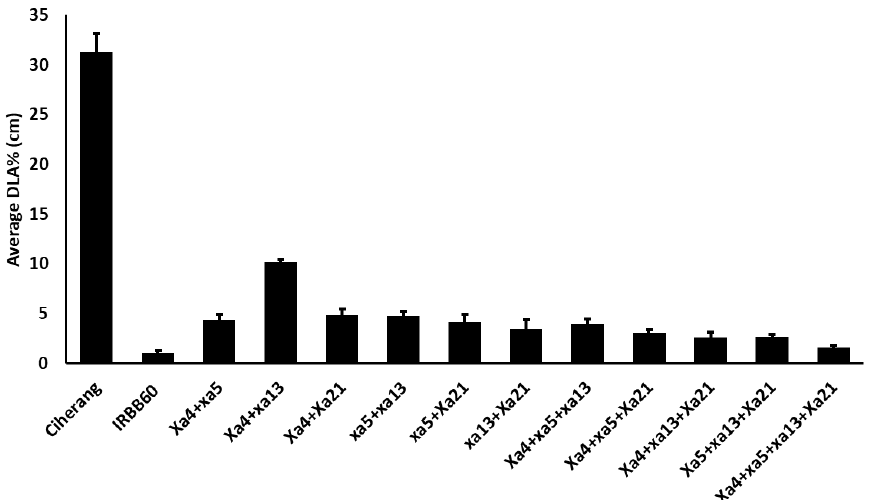
Figure 6. Percentage of disease infection of the 11 groups of pyramided lines with different combinations of genes.